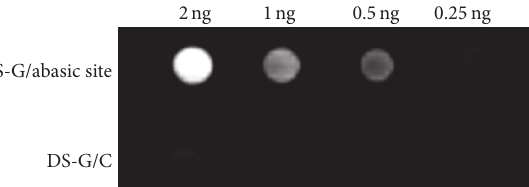
Figure 2: The serial dilutions after biotinylation were spotted on a nylon membrane. The chemiluminescent signals were detected by the chemiluminescent image analyzer.